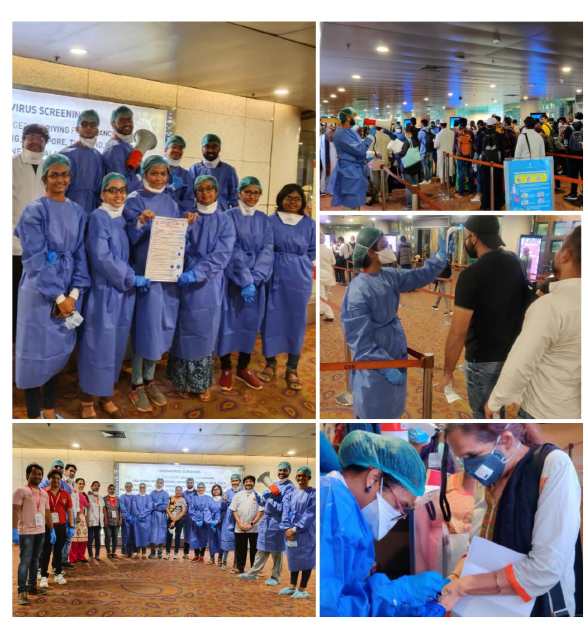
Figure 1 . Our Team of Doctors at Work at the International Arrival Terminal of CSI Airport, Mumbai.